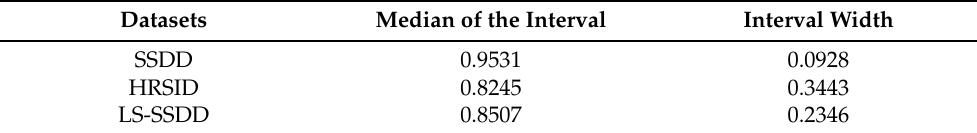
Table 3. The brightness intervals of SSDD, LS-SSDD, and